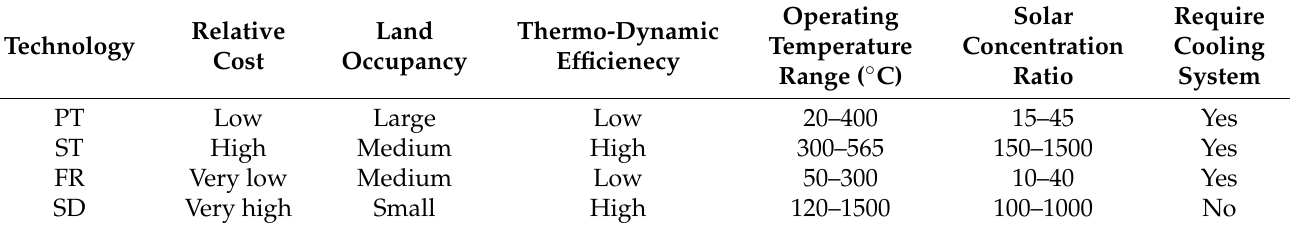
Table 3. Comparison of leading CSP technologies, reproduced with permission from [98,100].